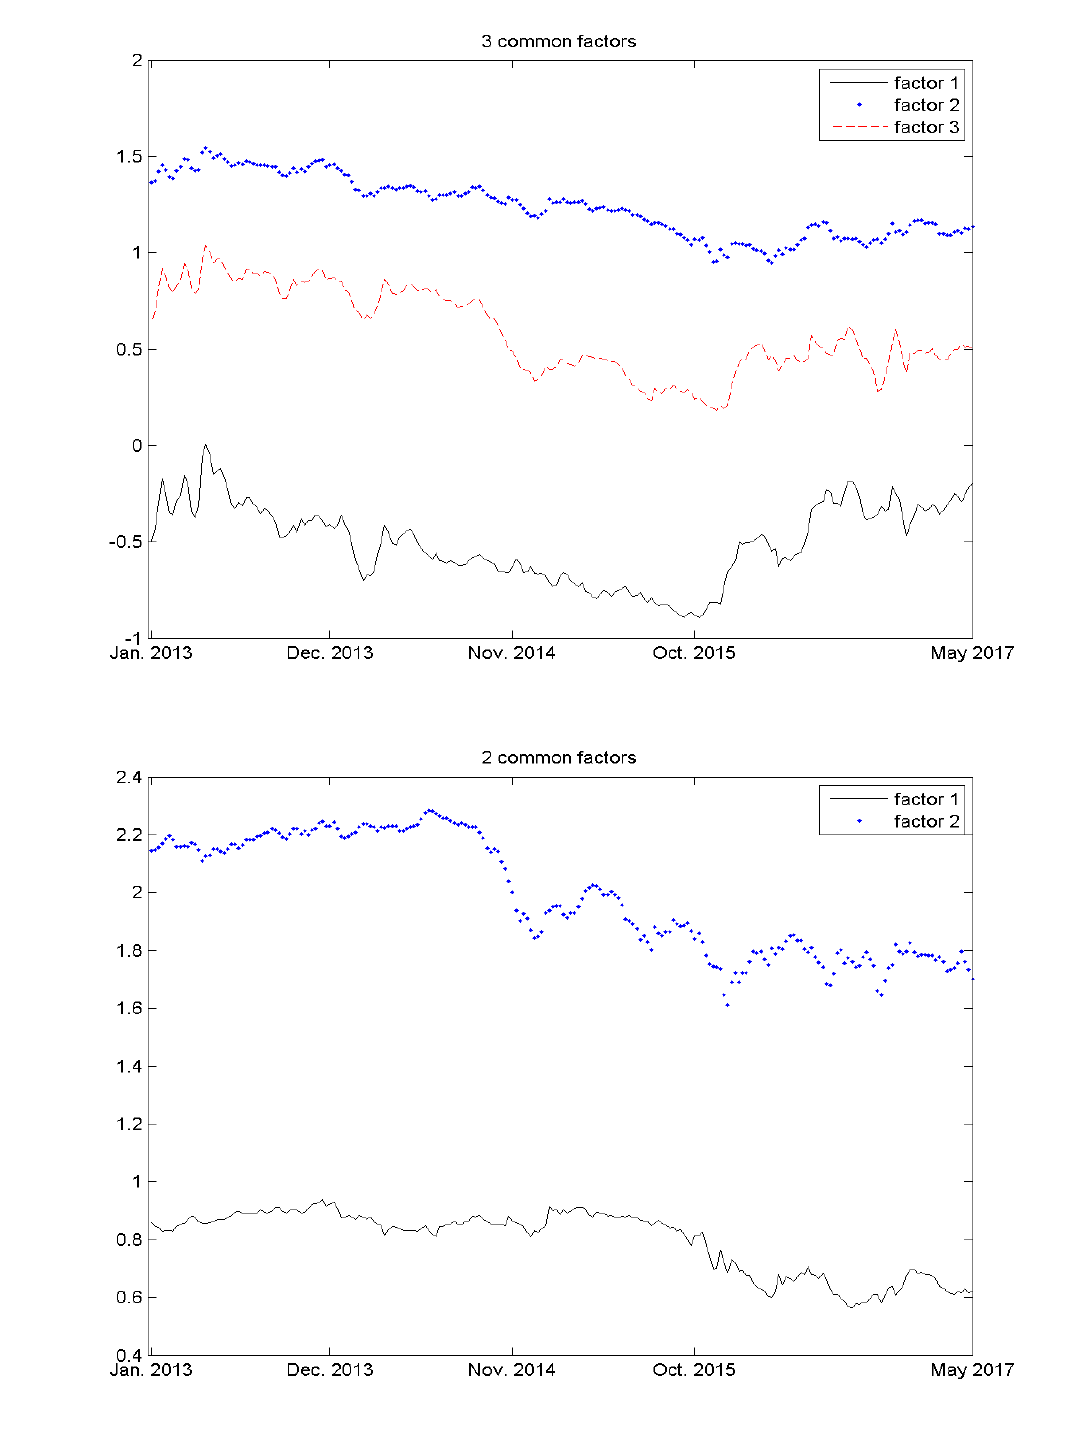
Figure 2. Common trends obtained from the Gonzalo–Granger permanent-transitory decomposition using weekly data from January 2013–May 2017. Top panel for EUA, coal, gas and Brent oil and bottom panel for coal, gas and Brent